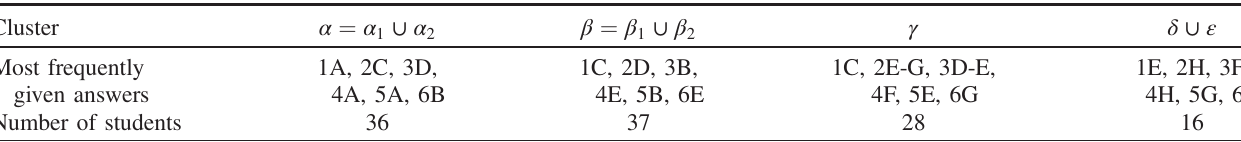
TABLE VII. An overview of results obtained by the H -CLA method: 4-cluster solution.